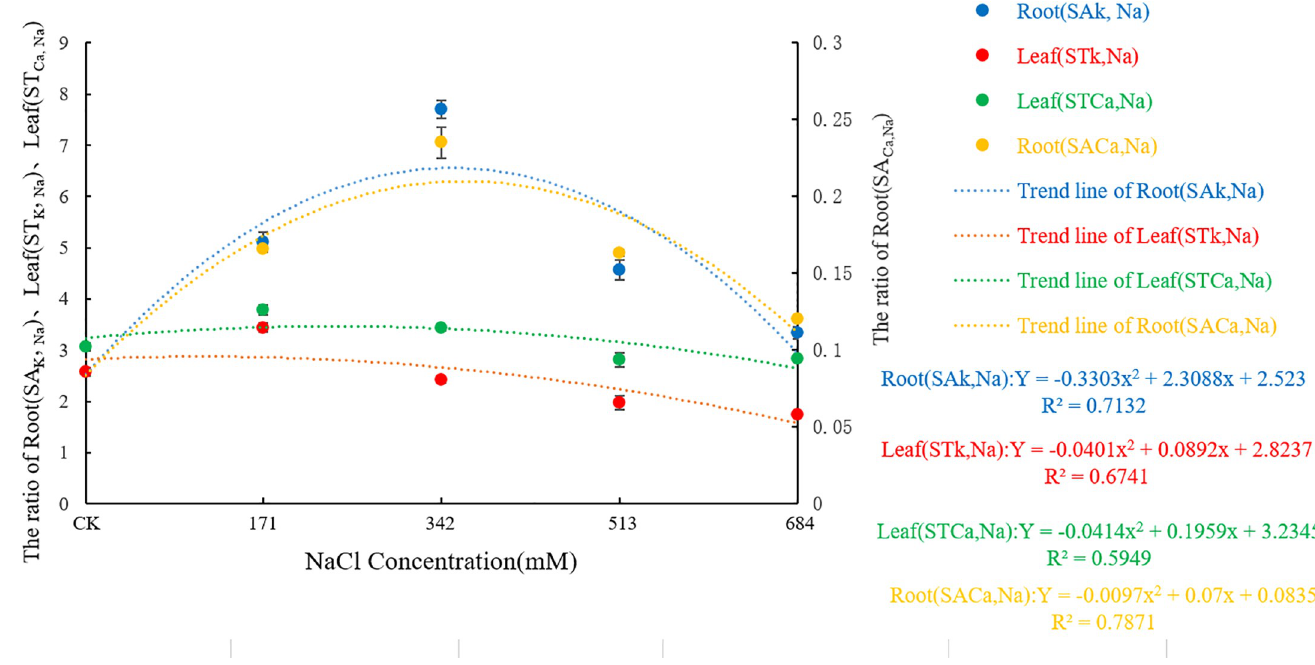
Fig 7. Effects of salt stress on selective uptake and transportation of ion in roots and leaves of Salix alba L.